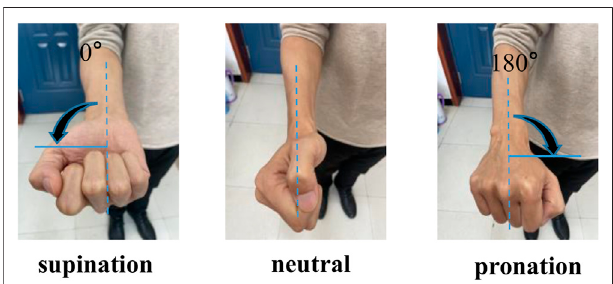
FIGURE 4 | Pronation – supination movement